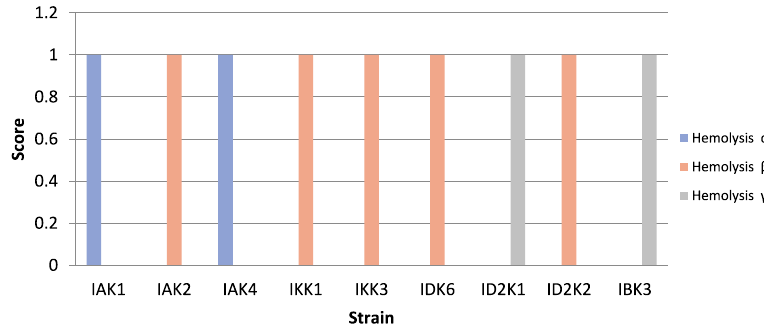
Fig. 3. Hemolytic test using blood agar assay Description: Score null = negative reaction, Score1 = positive reaction